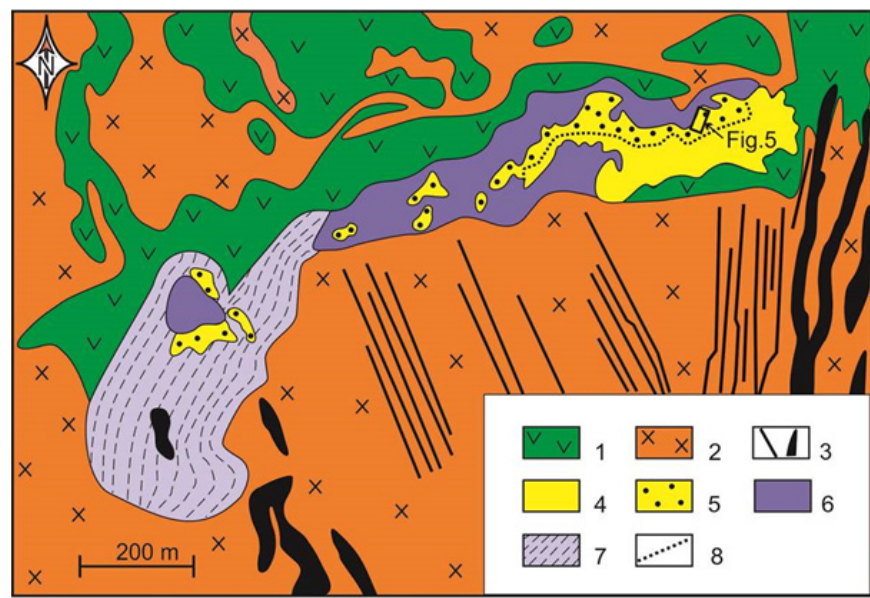
Figure 4. Simplified local geology of pyroxenite and nepheline-fassaite rocks and their surroundings. 1 = beerbachite after tholeiitic dolerite and gabbro; 2 = syenite; 3 = subalkaline gabbro and microgabbro; 4,5 = dolomite-bearing calcite marble (4) with abundant pyroxenite fragments (5); 6 = pyroxenite and nepheline-fassaite rocks; 7 = garnet-melilite-pyroxene and melilite-wollastonite metasomatic rocks; 8 = boundary between pyroxenite-bearing and pyroxenite-free marbles. Pyroxenite is a black fine-grained rock with variable percentages of nepheline: within 10% in pyroxenite proper and 30% to 50 % in nepheline-pyroxene rocks. The latter occur as randomly distributed irregularly shaped meters-long lenses in pyroxenite, with smooth boundaries. The mineralogy of pyroxenite and nepheline-pyroxene rocks consists of nepheline, amphibole, spinel, and rare calcite, perovskite, and biotite. Some pyroxenite samples contain rare disseminated Co-Ni-bearing loellingite or nickeline and wester-